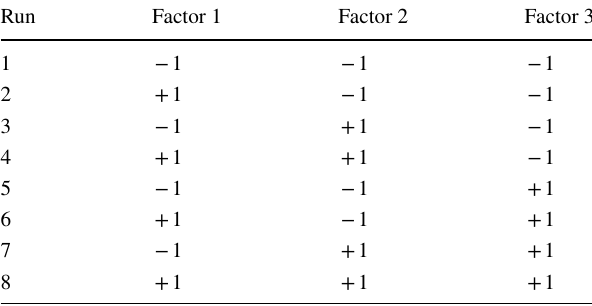
Table 3 Design matrix for 2 3 factorial designs Run Factor